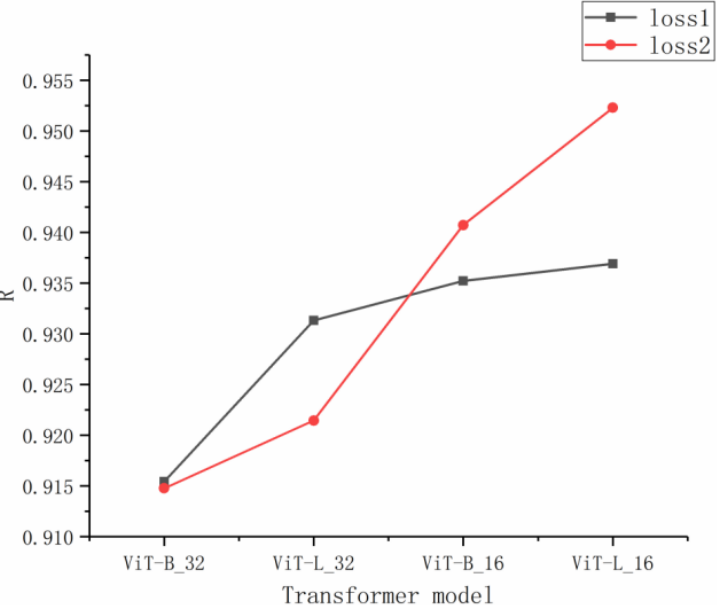
Figure 6. R of different transformer models based on the average of all four data division methods.